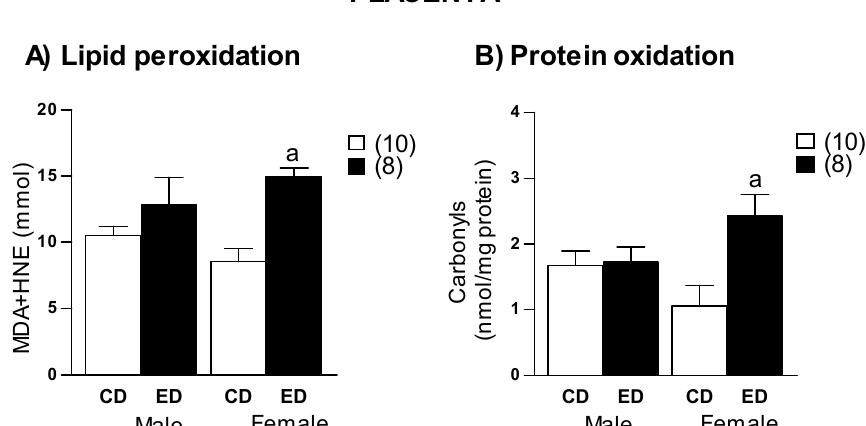
Figure 7. ( A ) Lipid peroxidation and ( B ) protein oxidation levels, in placentas from control diet (CD) and experimental diet (ED), separated by sex. MDA, malondialdehyde; HNE, hydroxynonenal. Data show mean ± SEM. Between parenthesis, the sample size is shown. ANOVA. a p < 0.001 ED versus CD.